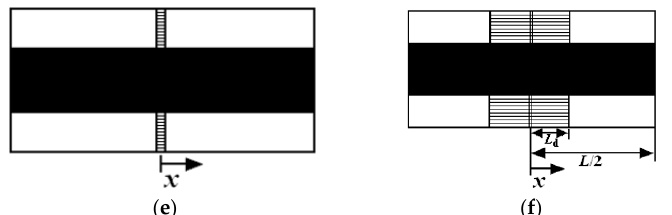
Figure 1. The undamaged state and five damaged modes of cross-ply and 2D woven ceramic composites: ( a ) undamaged composite; ( b ) mode 1: transverse cracking in the transverse tow, with debonding at tow boundary; ( c ) mode 2: transverse cracking and matrix cracking with perfect fiber/matrix bonding, and fracture of fibers occurs in the longitudinal tow; ( d ) mode 3: transverse cracking and matrix cracking with fiber/matrix debonding and sliding in the longitudinal tow; ( e ) mode 4: matrix cracking with perfect fiber/matrix bonding, and fracture of fibers occurs in the longitudinal tow; and ( f ) mode 5: matrix cracking and fiber/matrix interface debonding and sliding in the longitudinal tow [22].